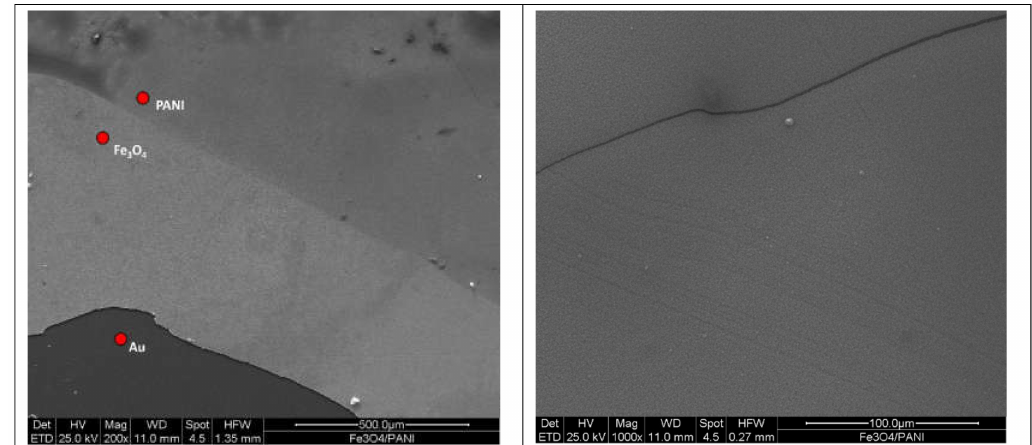
Figure 9. SEM micrographs (top-view) of the layered Au|Fe 3 O 4 |PANI specimen.